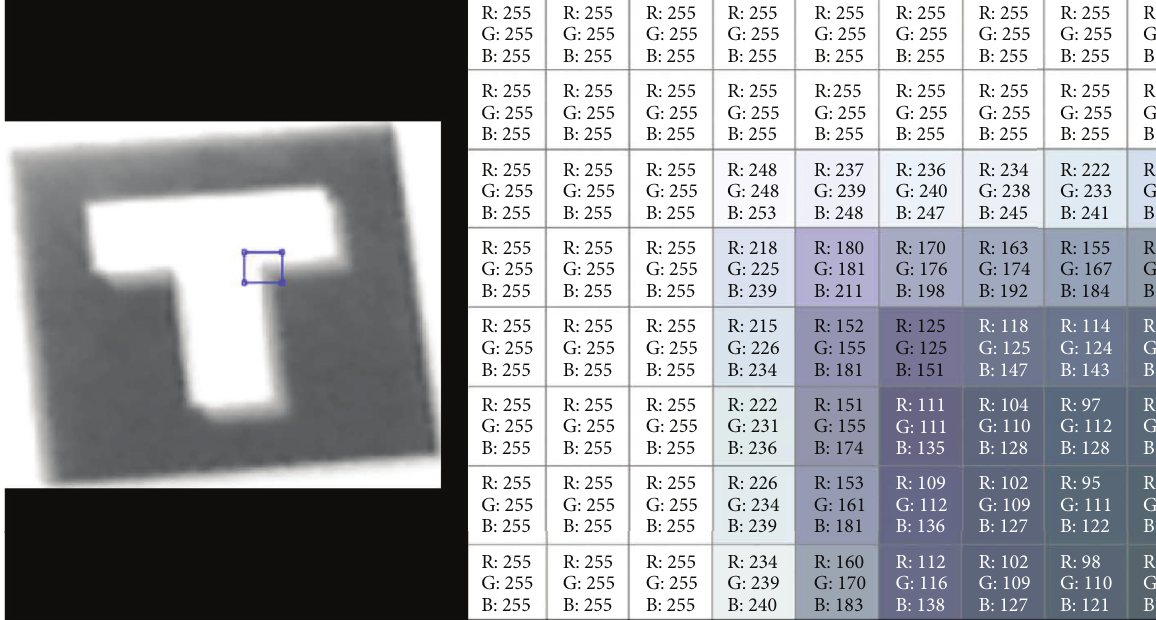
Figure 2: Binary serialization of “T” marker.